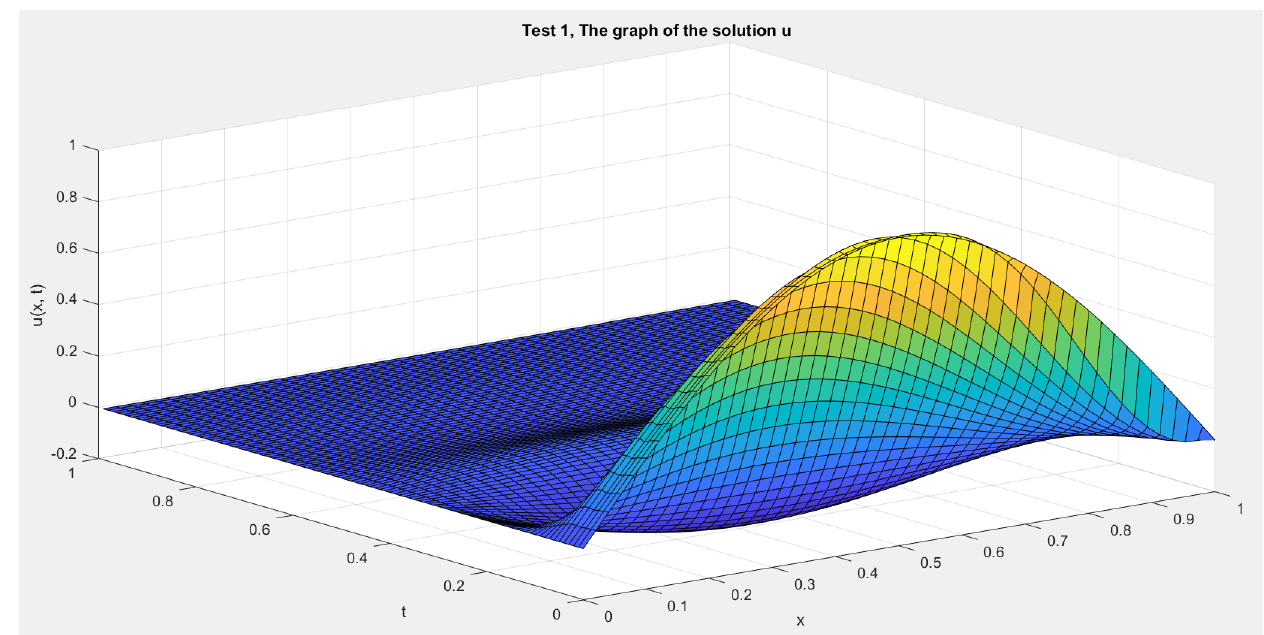
Figure 5. Test 1: The solution function u ( x , t )